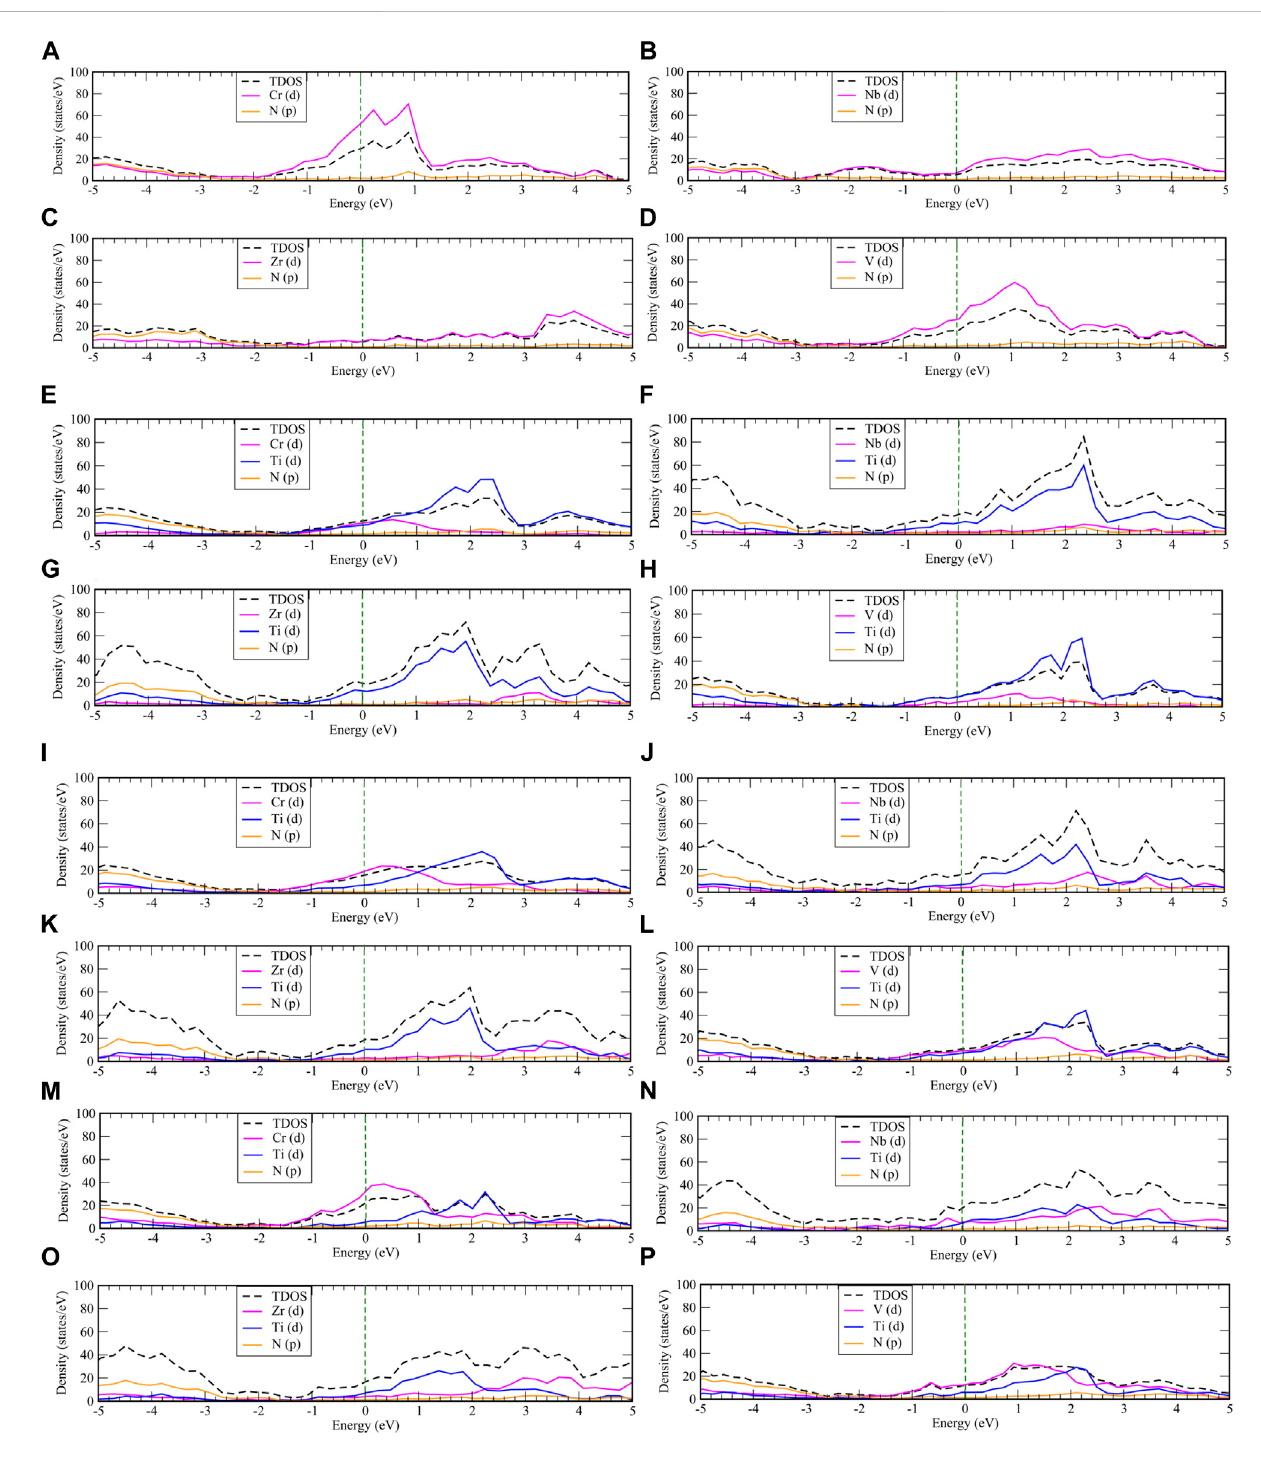
Thetotaland partialdensity ofstate ofpure (A) CrN, (B) NbN, (C) ZrNand (D) VN,oneoverlayer of (E) CrN, (F) NbN, (G) ZrN,and (H) VN,twooverlayersof (I) CrN, (J) NbN, (K) ZrN, and (L) VN, three overlayersof (M) CrN, (N) NbN, (O) ZrN, and (P) VN on TiN,respectively. The vertical dashed line indicates the Fermi